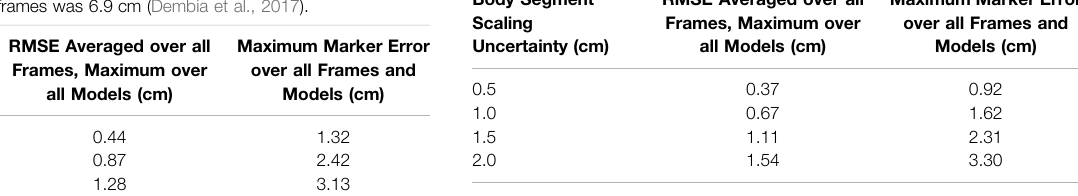
TABLE 1 | The effect of marker registration uncertainty on marker errors (with respecttothemarkerlocationsontheoriginalmodel) fromIK forvaryinglevels of uncertainty. For reference, the root-mean-square error (RMSE) for the original model with respect to experimental data was 2.1 cm and the maximum error across all markers and frames was 6.9 cm (Dembia et al., 2017).